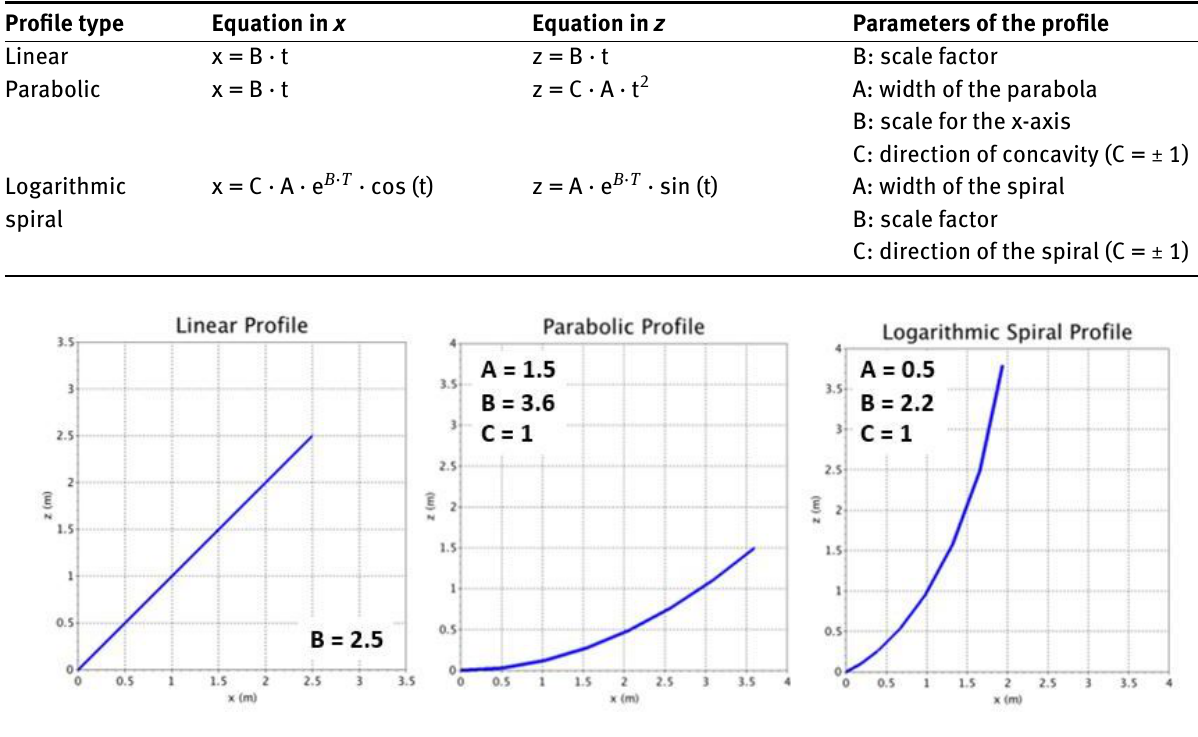
Figure 11: Examples of possible screen profiles, with their corresponding parameters Table 2: Optimum screen configuration for Receiver 01